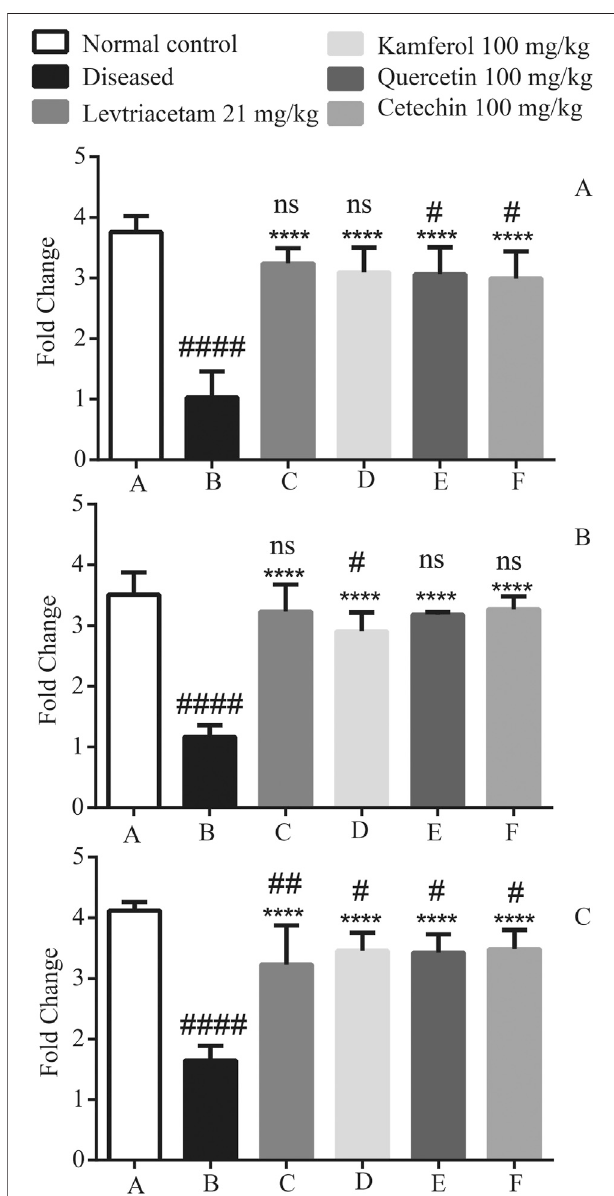
FIGURE 8 | Graphical representation of the mean ± SD relative expression levels of (A) IL-1Ra, (B) IL-4, and (C) IL-10. The treatment of PF signi fi cantly suppresses the pro-in fl ammatory cytokines. The data were analyzed by one-way ANOVA followed by Tukey ’ s post hoc test. Comparison of Group A vs B, C, D, E, and F denoted by (#), while Group B vs C,D,E,andFisdenotedby(*).* p < 0.05.** p < 0.01,*** p < 0.0005,and**** p <